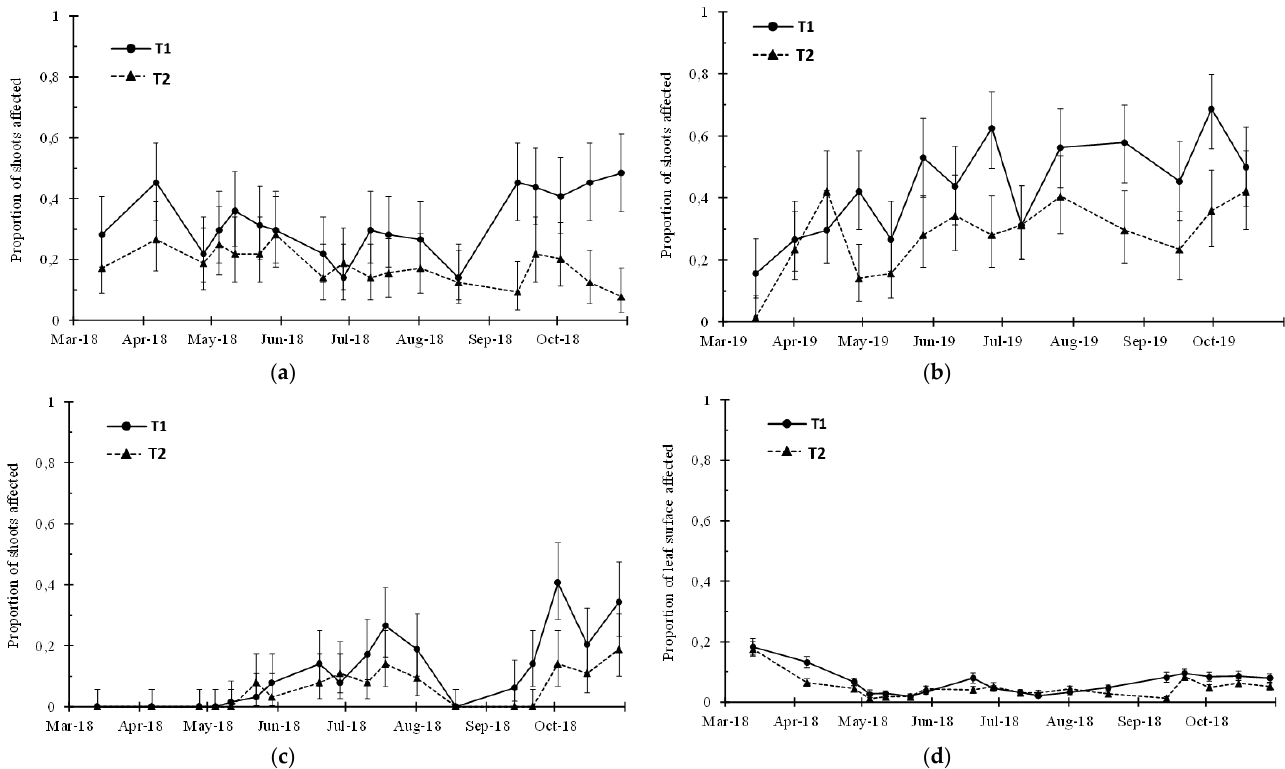
Figure 4. Evolution along time for the proportion of the most important observations made using visual sampling in the two irrigation treatments: ( a ) Eriophyidae in 2018, ( b ) Eriophyidae in 2019, ( c ) Palpita unionalis and Zelleria oleastrella in 2018, and ( d ) feeding spots on the leaf surface in 2018. The solid line represents treatment T1 (control), and the dotted line represents treatment T2 (Confederation RDI). The vertical bars represent the exact confidence interval of a proportion, except for in d), which represents the standard error of the proportion.